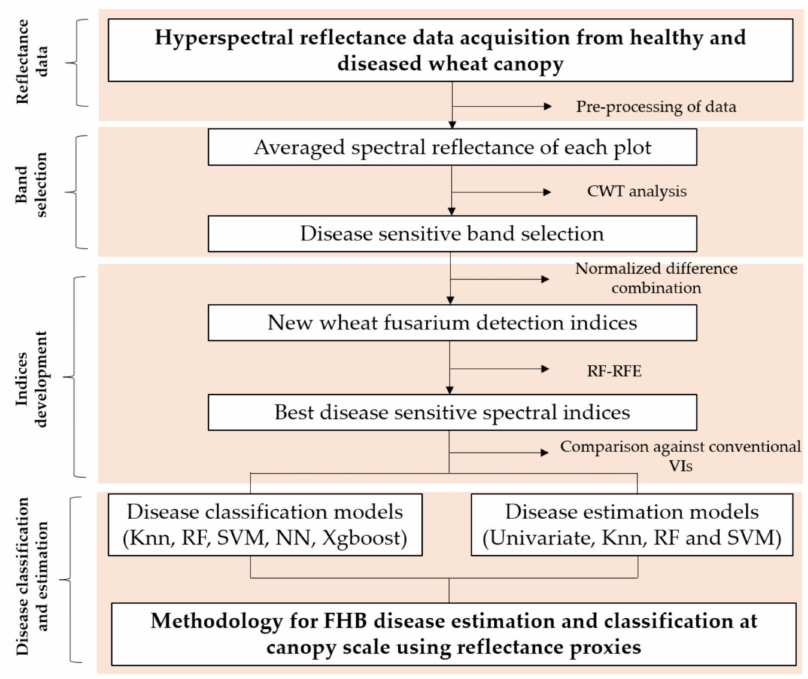
Figure 2. Workflow of the